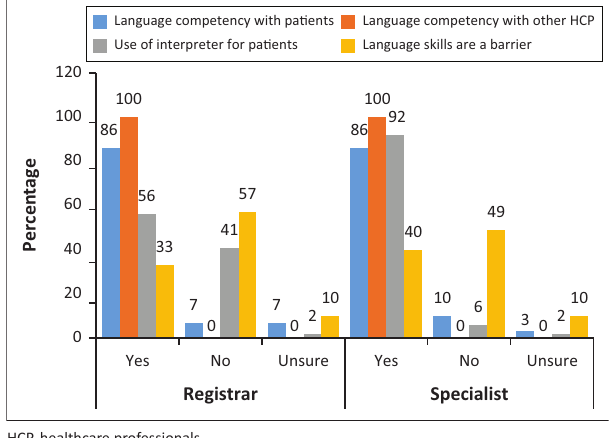
FIGURE 1-A1: Language skills with patients and other healthcare